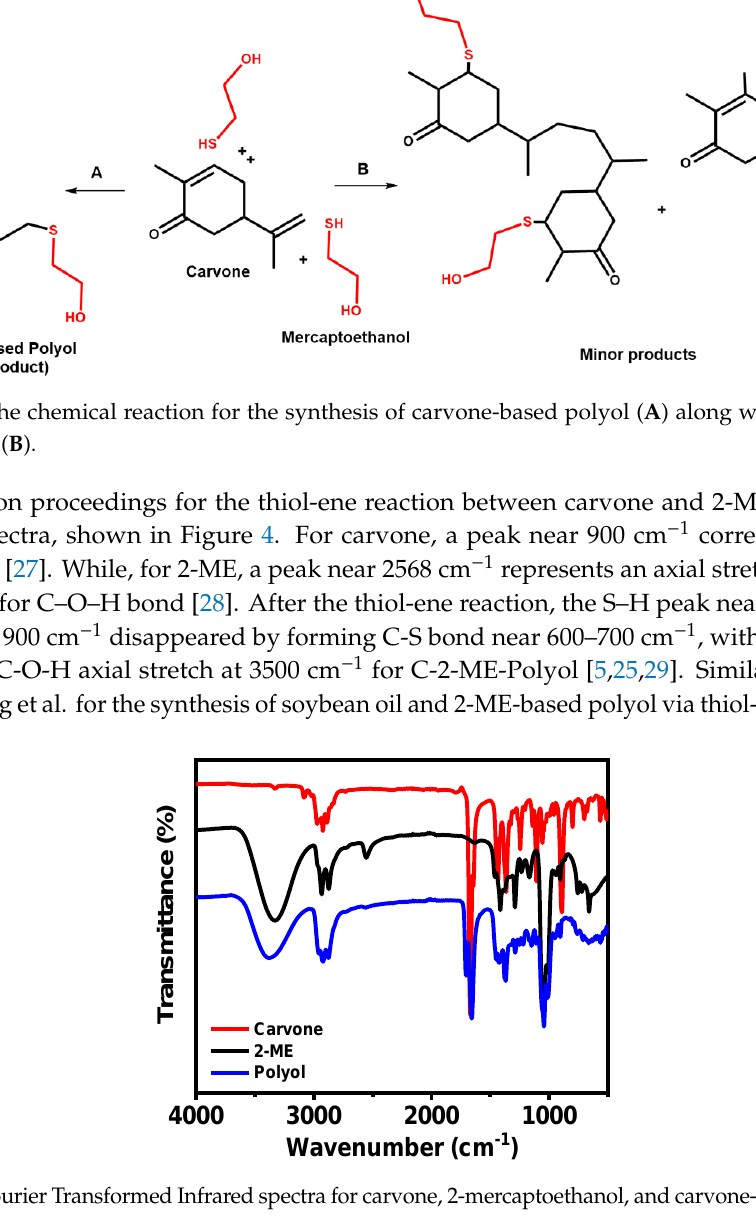
Figure 5. Density of polyurethane foams with carvone-based polyol with an increasing amount of EG.